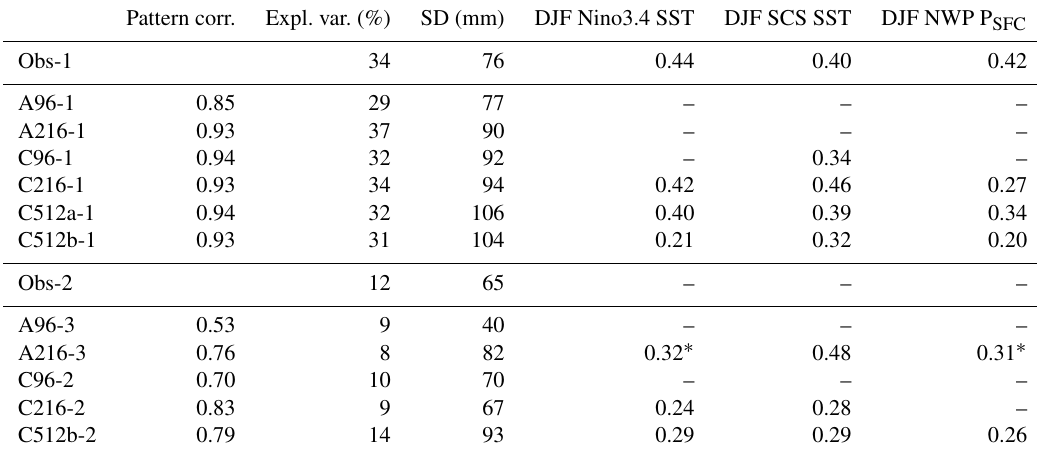
Table 1. Performance statistics of simulated EOTs compared to observations for DJF. Column (1) observed (Obs) and simulated (labelled by simulation name) EOT patterns; numbers indicate the order of the EOT pattern. (2) Linear pattern correlation coefficient of simulated and observed precipitation anomalies; (3) explained space–time variance of the EOT pattern; (4) standard deviation of the EOT time series; (5)–(7) Spearman’s rank correlation of the EOT time series with the (5) Niño3.4 SST index; (6) SCS SST index and (7) NWP P SFC index (defined in Sect. 2.3). Correlation coefficients in (5)–(7) are shown only when they are significant at the 90% confidence level and are marked with an asterisk for confidence levels <